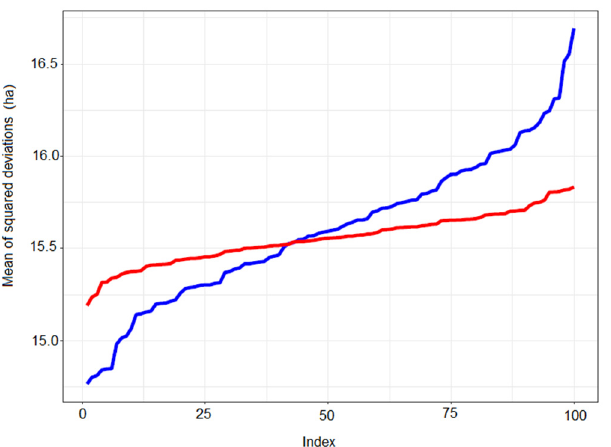
Figure 8. Comparison of the squared deviation for the neutral network based on the Prométhée database from 1973 to 2005 concerning the burnt surface.